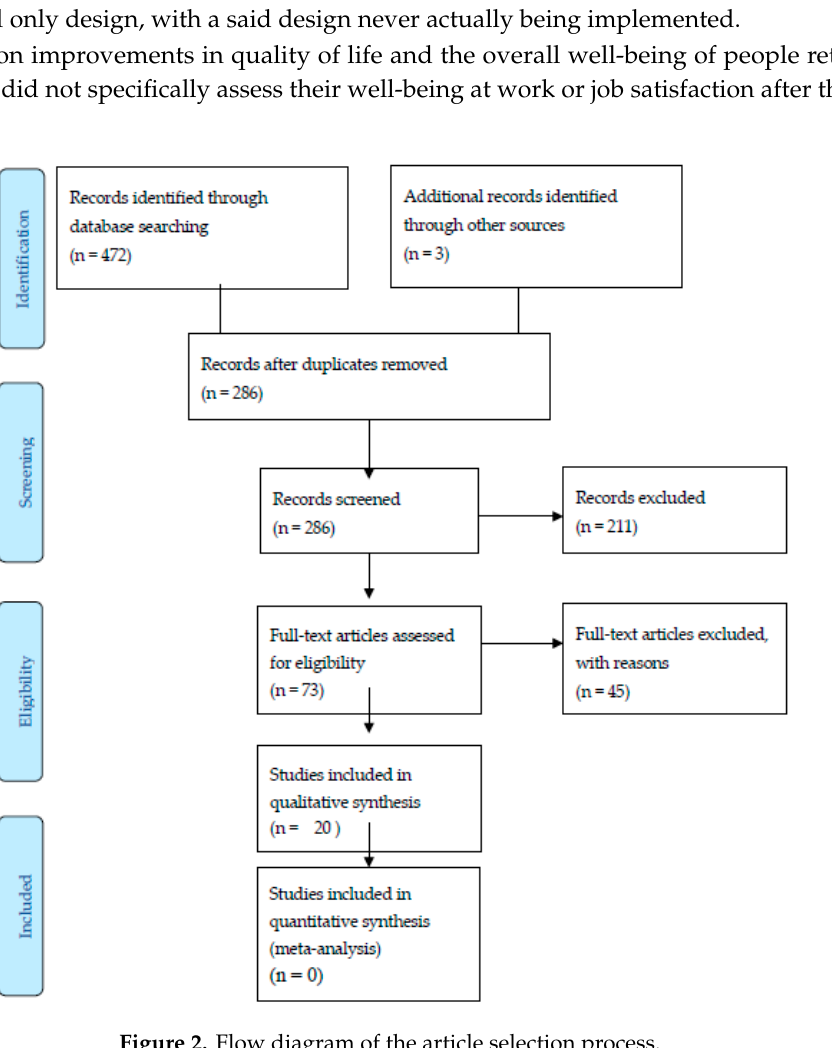
Figure 2. Flow diagram of the article selection process.